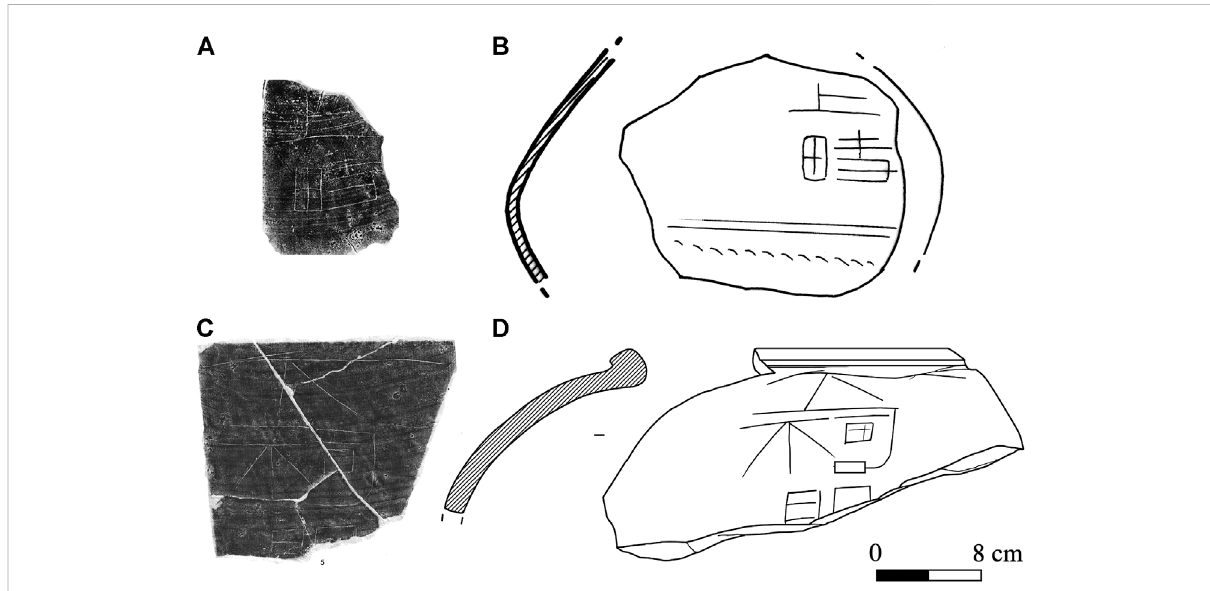
(Supplementary Table S1) for the fi rst round. After completing the above measurements, we conducted a second-round sampling on the four most likely outliers to investigate their intra-teeth 87 Sr/ 86 Sr variations. Sampling took place along the enamel pro fi le, starting from tooth cervix and advancing toward the apex, yielding seven samples each in near-evenly spaced intervals (Figure 6). This sampling strategy allowed to evaluate the isotopic signals from an individual and constrain the relative range where the tooth formed with a higher temporal resolution.